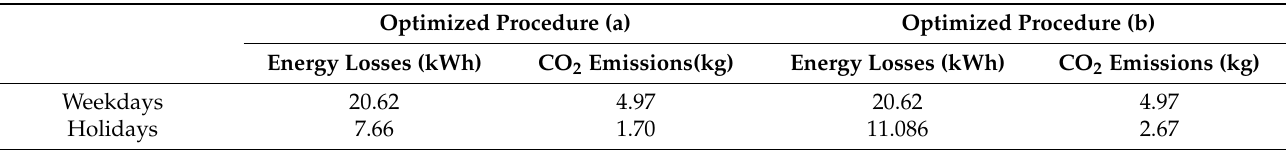
Table 9. Annual energy losses and carbon dioxide emissions caused by reactive currents in the transformer operation with optimized operation of capacitor